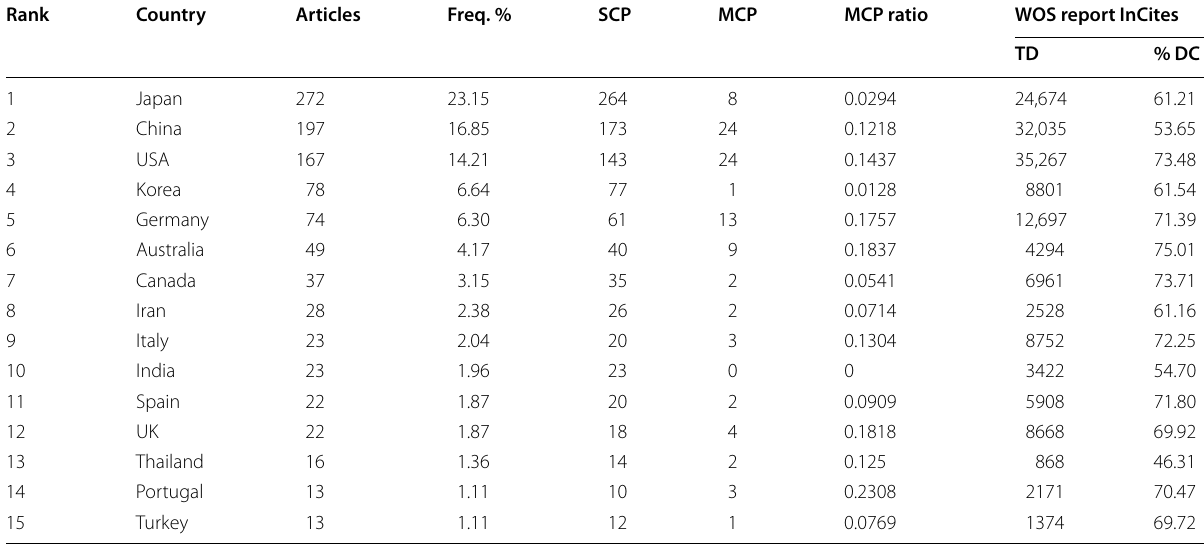
Table 9 Top 15 countries contributed to RR